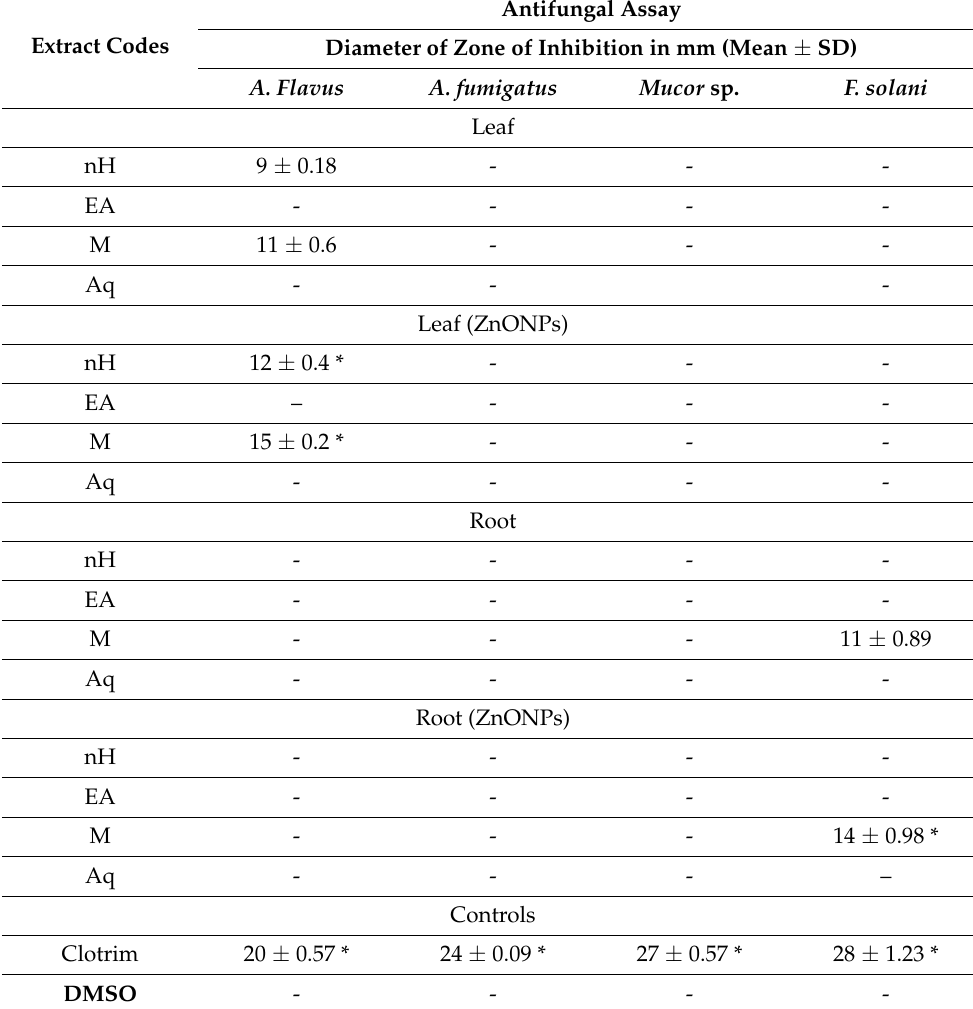
Table 3. Antifungal activity and ZOI values of W. somnifera crude extracts and ZnNPs.